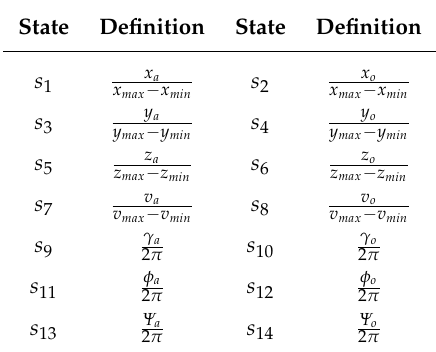
Table 1. The state space for the aerial combat model.